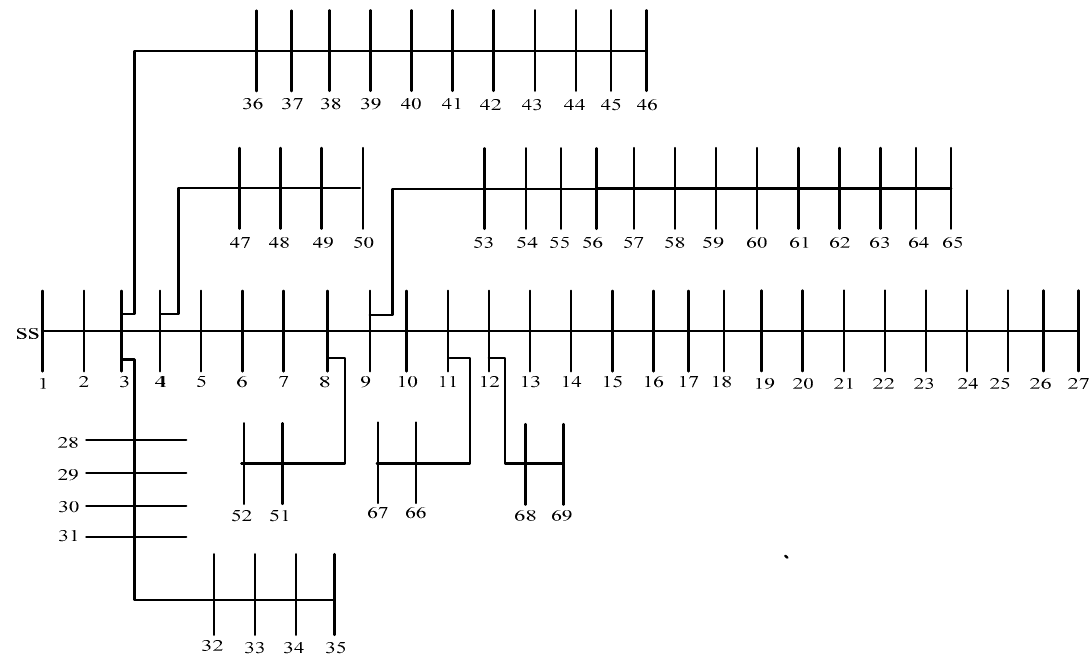
Figure 7. Sample line diagram of standard 69-bus test system.